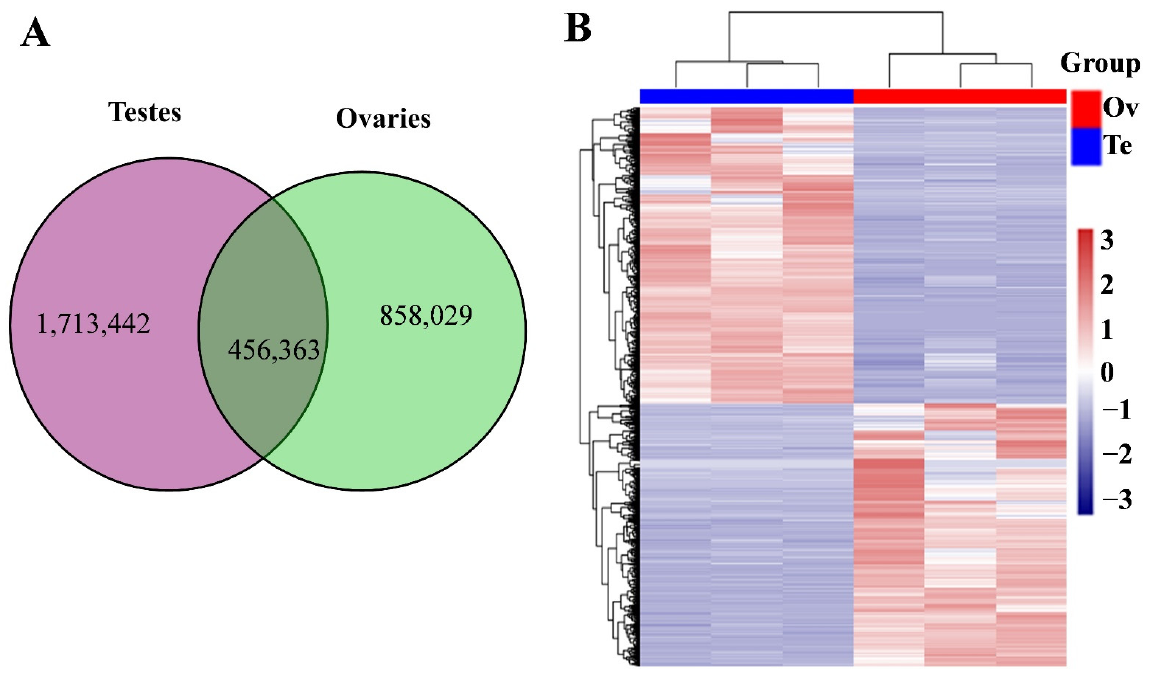
Figure 2. piRNA expression pattern in testes and ovaries. ( A ) Venn diagram showing shared and unique piRNAs in testes and ovaries. ( B ) Heatmap showing the significantly different piRNA expression between testes (Te) and ovaries (Ov). Columns indicate samples and rows indicate piRNAs. Red indicates high expression and blue indicates low expression.